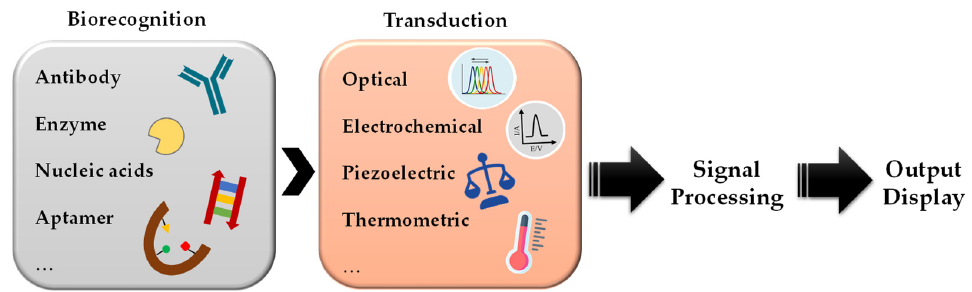
Figure 1. Schematic representation of a biosensor.